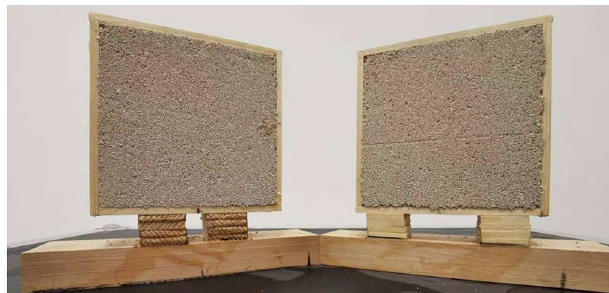
Figure 1. Two displayed specimens.